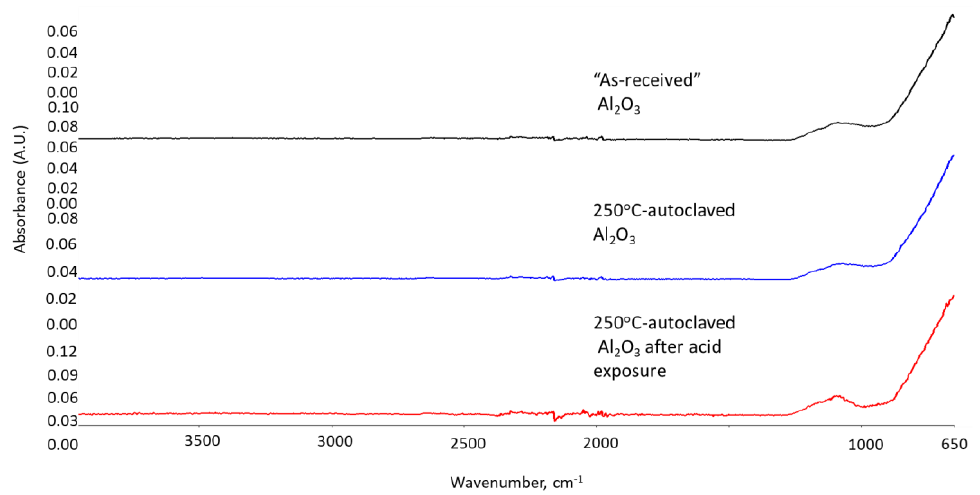
Figure 14. FTIR spectra of aluminum oxide samples from top to bottom: “as received” (before exposure) aluminum oxide, 250 °C-autoclaved aluminum oxide and aluminum oxide exposed to the strong acid.